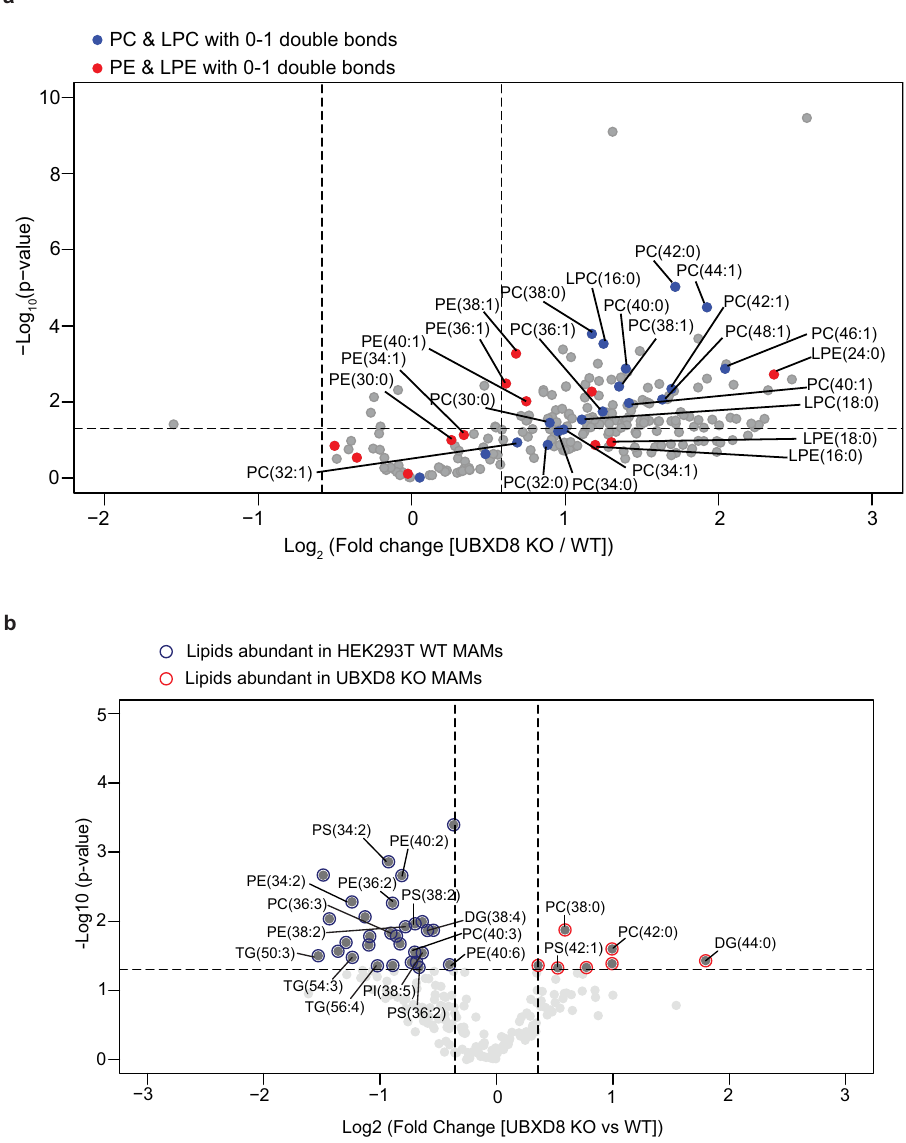
Fig. 5 | Quantitative lipidomics of MAMs identi fi es a role for UBXD8 in reg- ulating fatty acid composition at ERMCS. a , b Volcano plot of the ( − log 10 transformed P value vs the log 2 -transformed ratio of UBXD8 KO: wildtype) total phospho-andneutrallipidspeciesidenti fi edusinglipidomicsofwholecellextracts ( a ) or MAM fractions ( b ) of HEK293T cells. PC, LPC species (blue fi lled circles) and PE,LPEspecies(red fi lledcircles)withsaturatedormonounsaturatedfattyacidtails are labeled in a . Lipid species with saturated or monounsaturated fatty acid tails (red outline) or polyunsaturated fatty acid tails (blue outline) are labeled in the lipidomics of MAM fractions in b . Lipids were measured by LC-MS/MS following